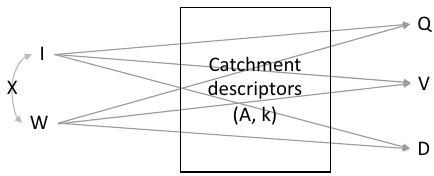
Figure 3. Path diagram between meteorological (exogenous) variables I and W, and the flood (endogenous) variables: Q, V, D. I and W can be dependent (represented by a curved line with arrowheads at each end) or independent (represented with the symbol × on the curved line) each other. The connection between each meteorological variable and each flood variable is filtered by the catchment descriptors (A, k, in this case) and represented by an arrow that goes from each cause to the